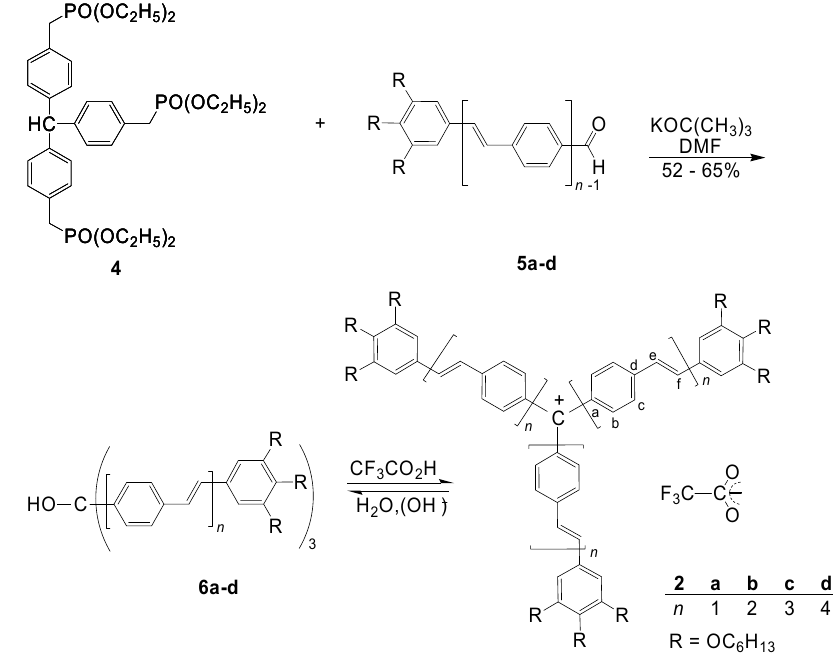
Figure 6. Maxima of the long wavelength absorption of the carbinols 6a-d ( □ , measured in CHCl ) and their salts 2a-d ( ■ , measured in CHCl 3